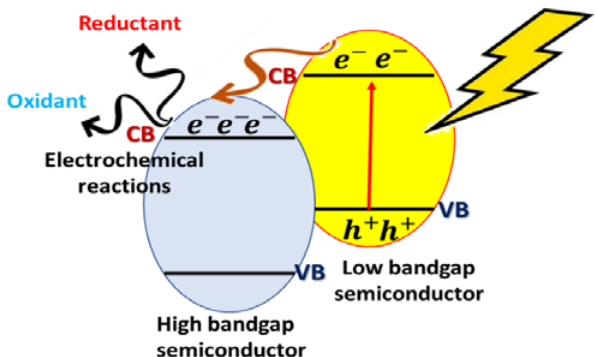
Figure 13. Schematic illustrating the heterojunctions produced from one visible-light-active compo- nent and other UV-light-active component.